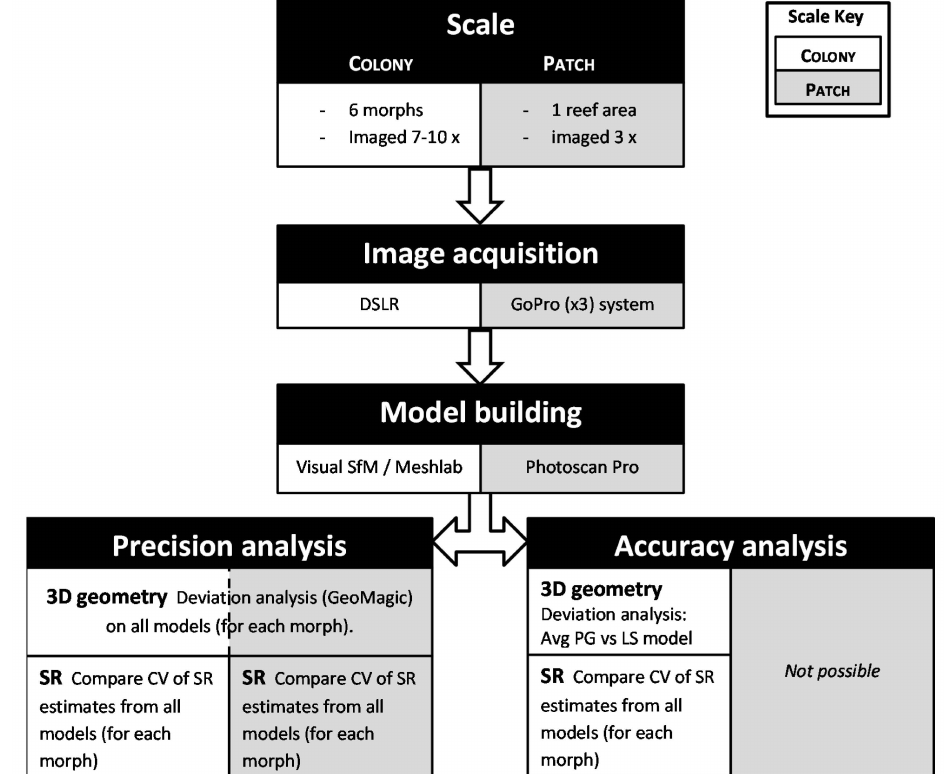
Figure 1. Flow diagram of project methodology indicating the systems used to acquire images, build models and conduct precision and accuracy analysis for each of the two spatial scales, colony and reef patch. SR = surface rugosity, PG = photogrammetry and LS = laser scan. For detailed methodology of individual steps see